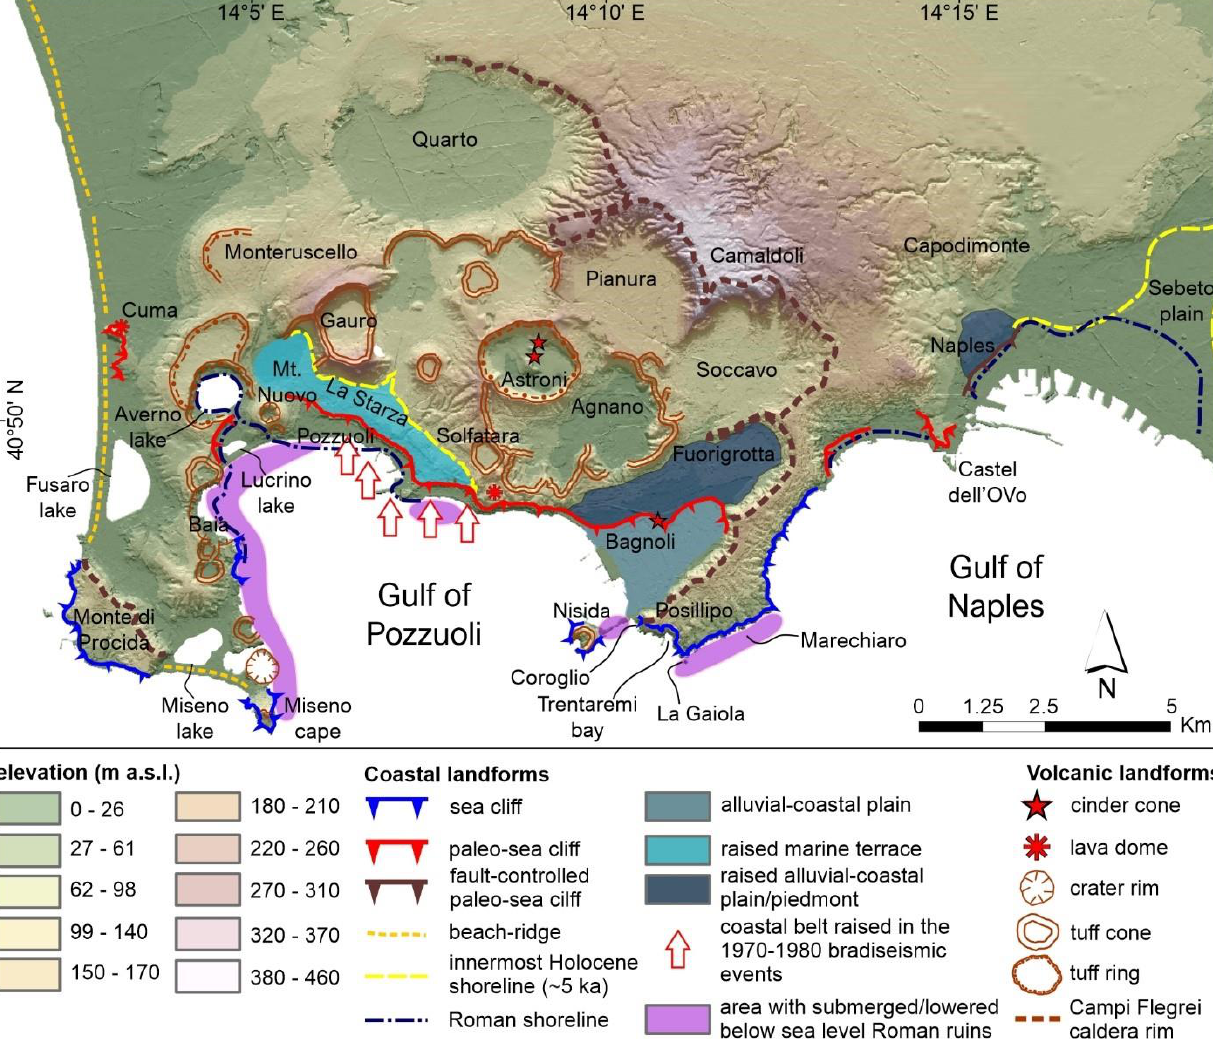
Figure 2. Geomorphological map of the Campi Flegrei (modified from [10]). The Campi Flegrei’s history is also characterized, besides volcanic activity, by ground motions in the form of episodes of uplift and subsidence during bradyseismic crises [48,49]. These episodes range from several meters to several tens of meters and continue nowadays (Figure 2) [50–53]. Ground motions are testified to, above all, by the raised marine terrace of La Starza (Figure 2), near Pozzuoli [43,50,51,54], and by submerged archaeological ruins near Baia, Nisida, La Gaiola and Castel dell’Ovo [19,51,52,55,56] (Figure 2). The complex volcanic history of the Campi Flegrei has influenced its geomorphological setting, which results in a hilly landscape mainly modelled by slope, volcanic and coastal processes. Elevation within the Campi Flegrei spans from 0 m a.s.l. to 460 m a.s.l., with the highest peak corresponding with the Camaldoli hill (Figure 2). Slope processes include landslides affecting the volcanic slopes that often cause severe damage to people and buildings [57]. Volcanic landforms are clustered within the caldera’s inner slope and consist of tuff rings, tuff cones, cinder cones and lava domes formed by volcanic events in the last 15 ka ([10] and reference therein). Coastal landforms consist of both sandy and rocky coasts. Sandy coasts occur near the main alluvial plains, e.g., the Sebeto and the Fuorigrotta-Bagnoli plain (Figure 2) and